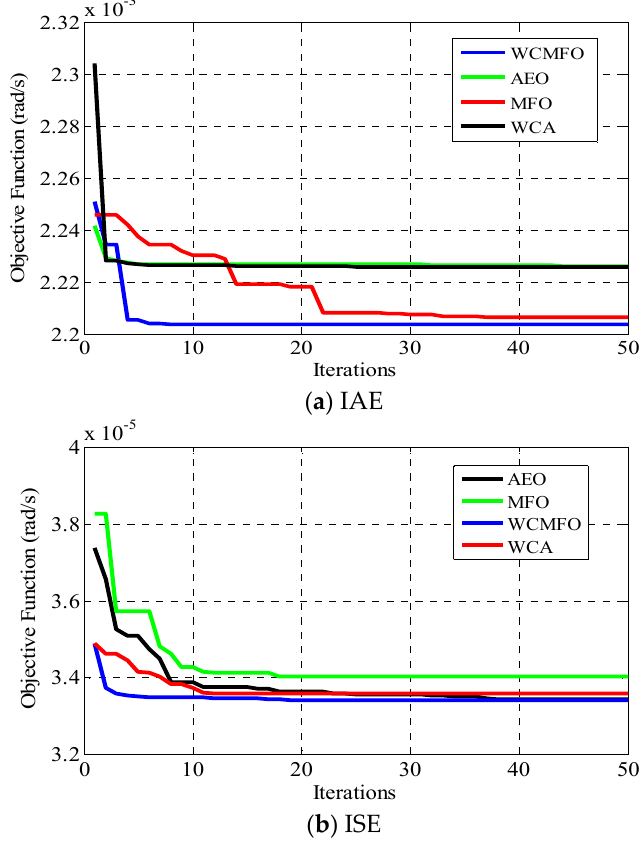
Figure 5. Convergence profile ( a ) IAE, ( b ) ISE using PSS controller.